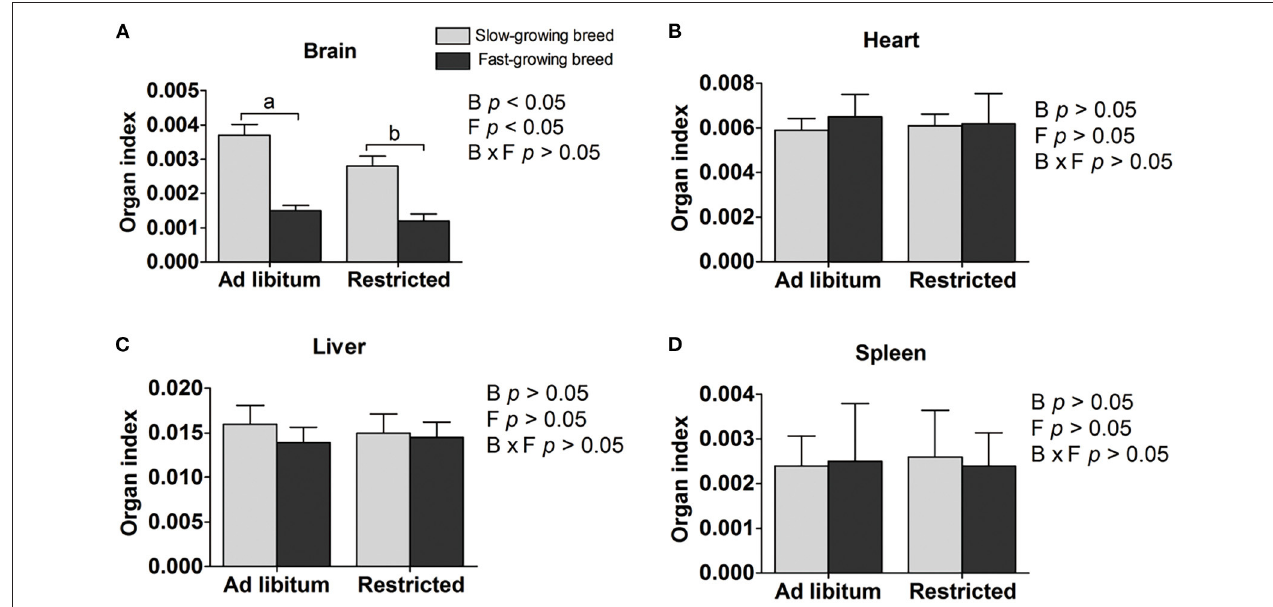
FIGURE 1 | Organ indexes of brain (A) , heart (B) , liver (C) , and spleen (D) between slow-growing and fast-growing breed birds. SA, slow-growing dual-purpose chickens ad libitum ; SR, slow-growing dual-purpose chickens feed restriction; FA: fast-growing broilers ad libitum ; FR, fast growing broilers feed restriction. a, b means the significant difference between ad libitum vs feed restriction in the same